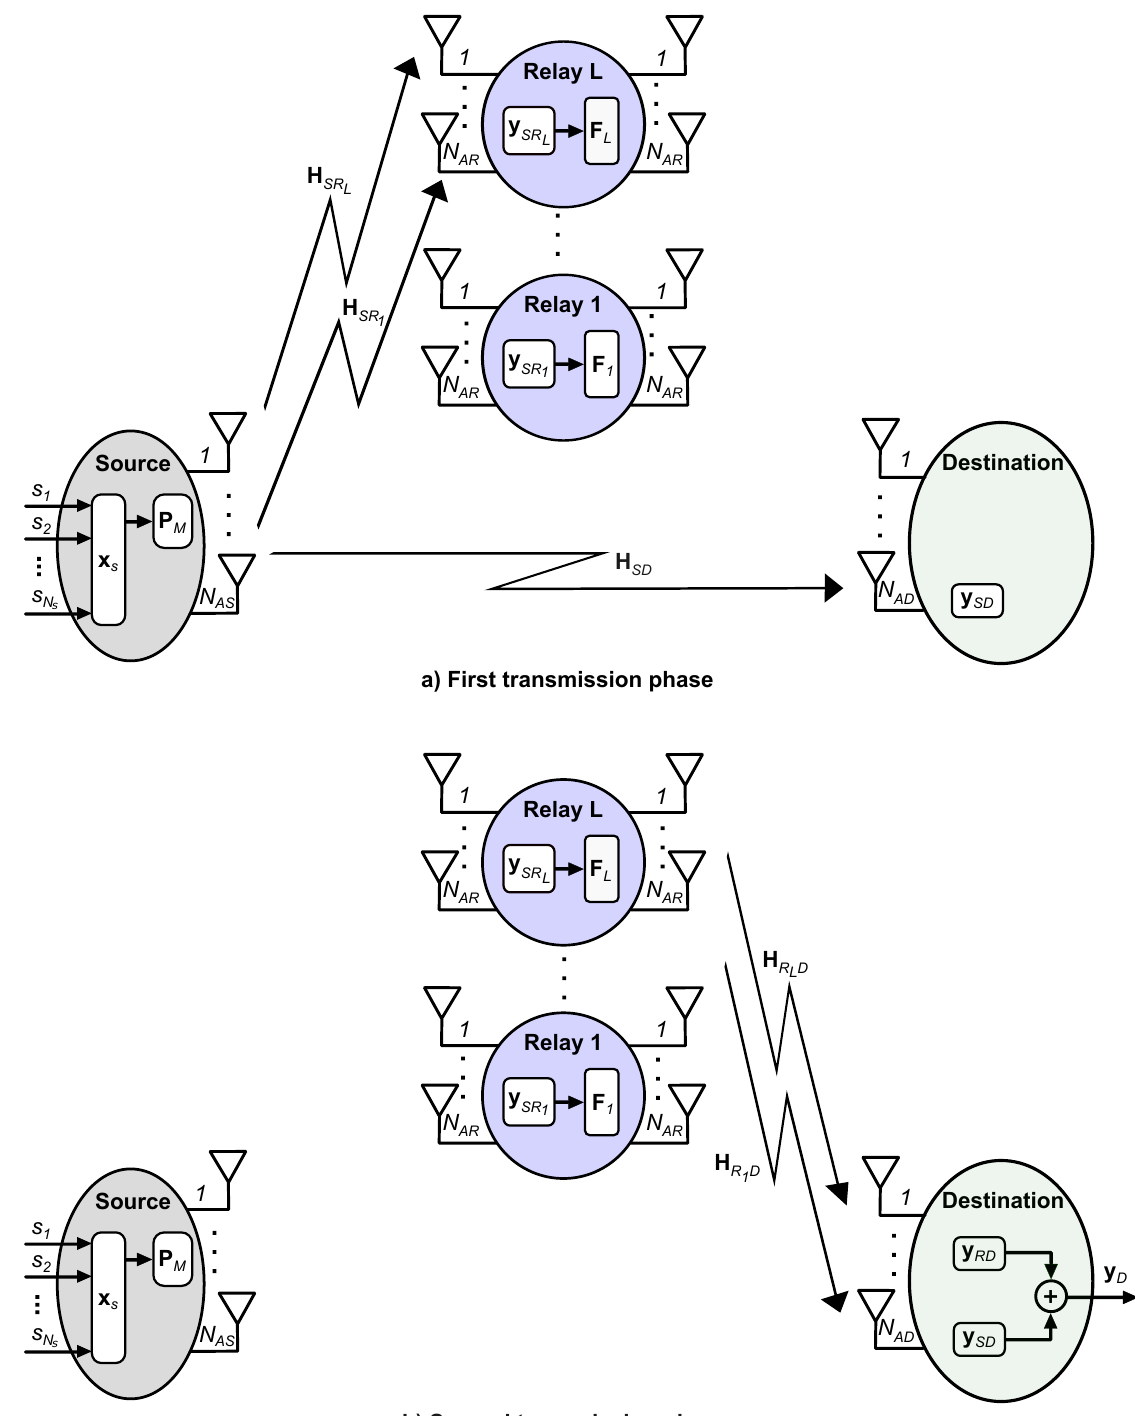
Figure 1. Multi-relay cooperative MIMO systems using one source, one destination and L